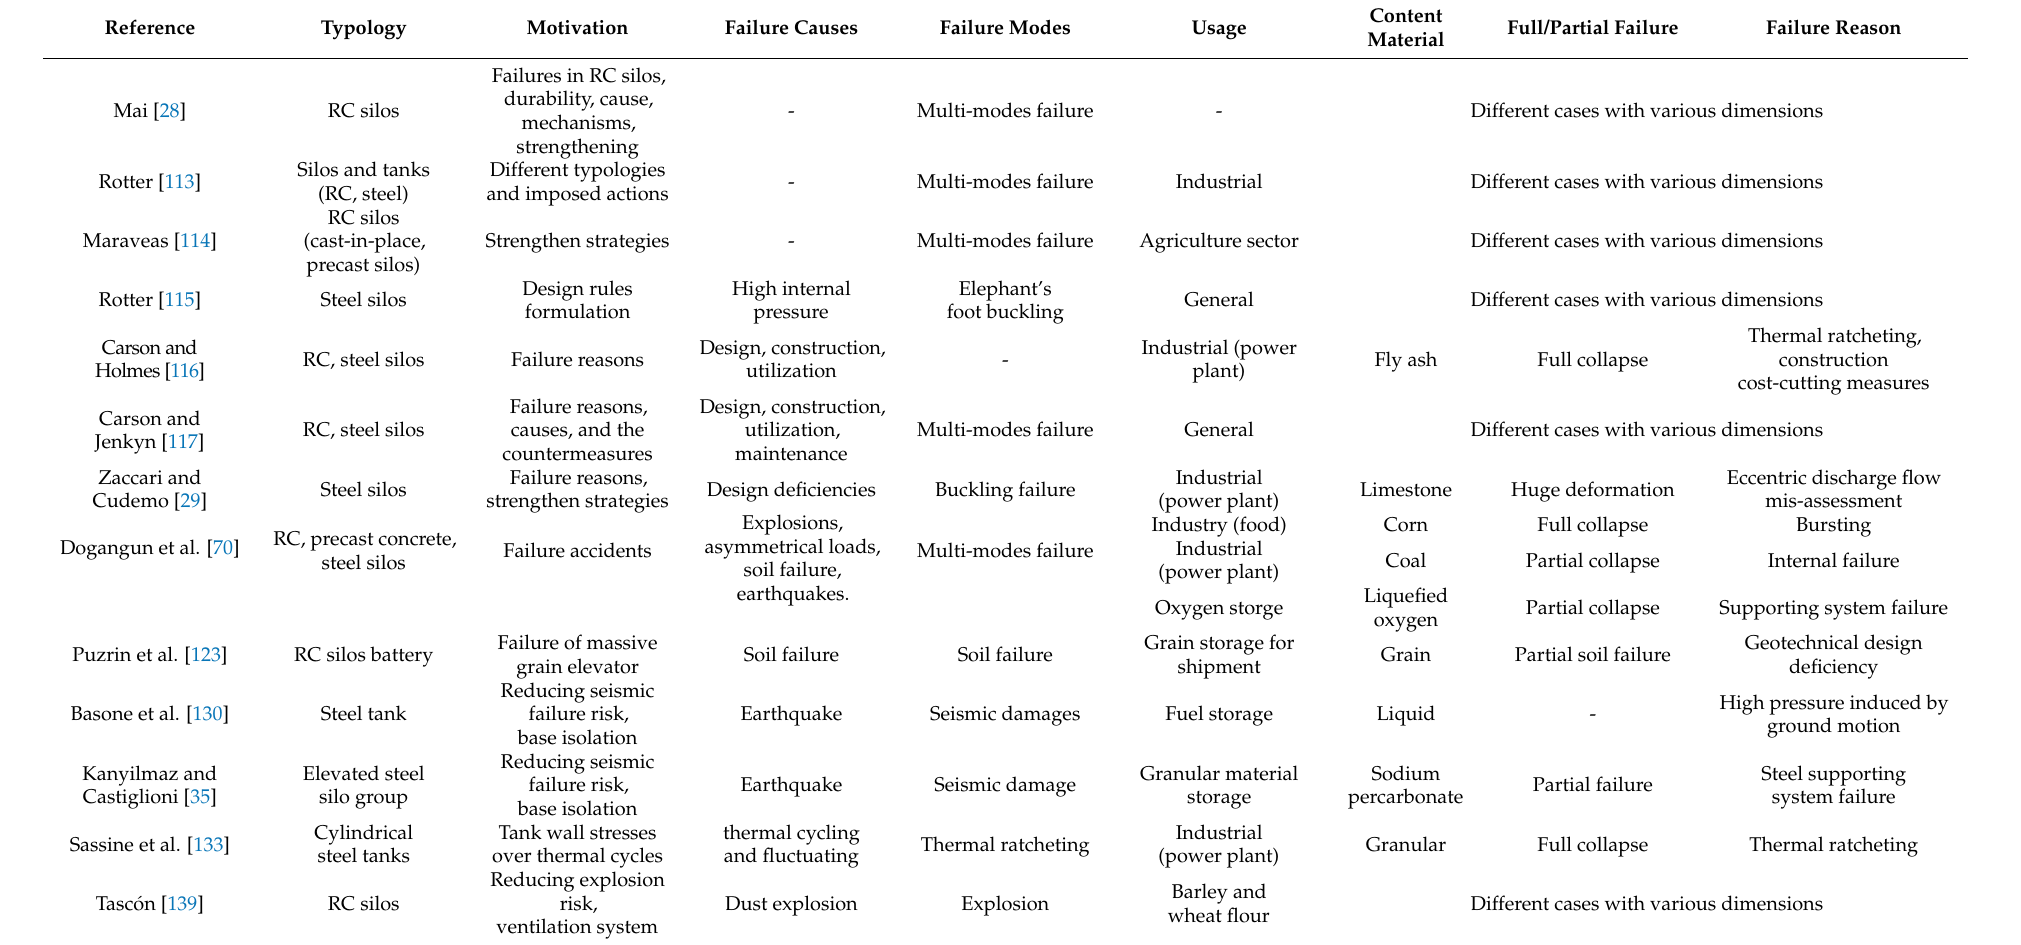
Table 3. Main failures modes and causes of